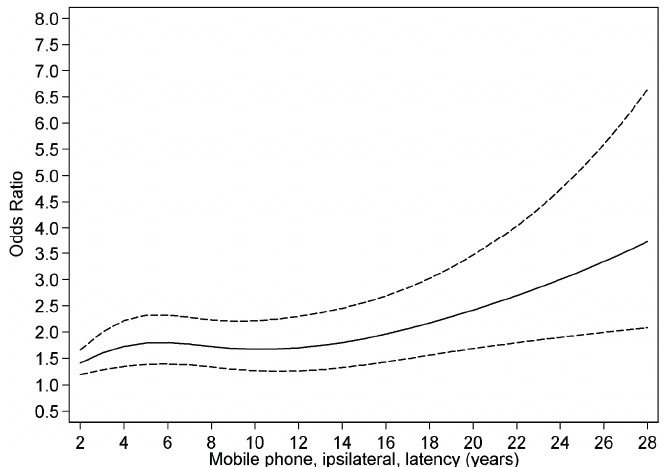
Figure 7. Restricted cubic spline plot of the relationship between latency of ipsilateral mobile phone use and glioma. The solid line indicates the OR estimate and the broken lines represent the 95% CI. Adjustment was made for age at diagnosis, gender, SEI-code and year for diagnosis. Population based controls were used